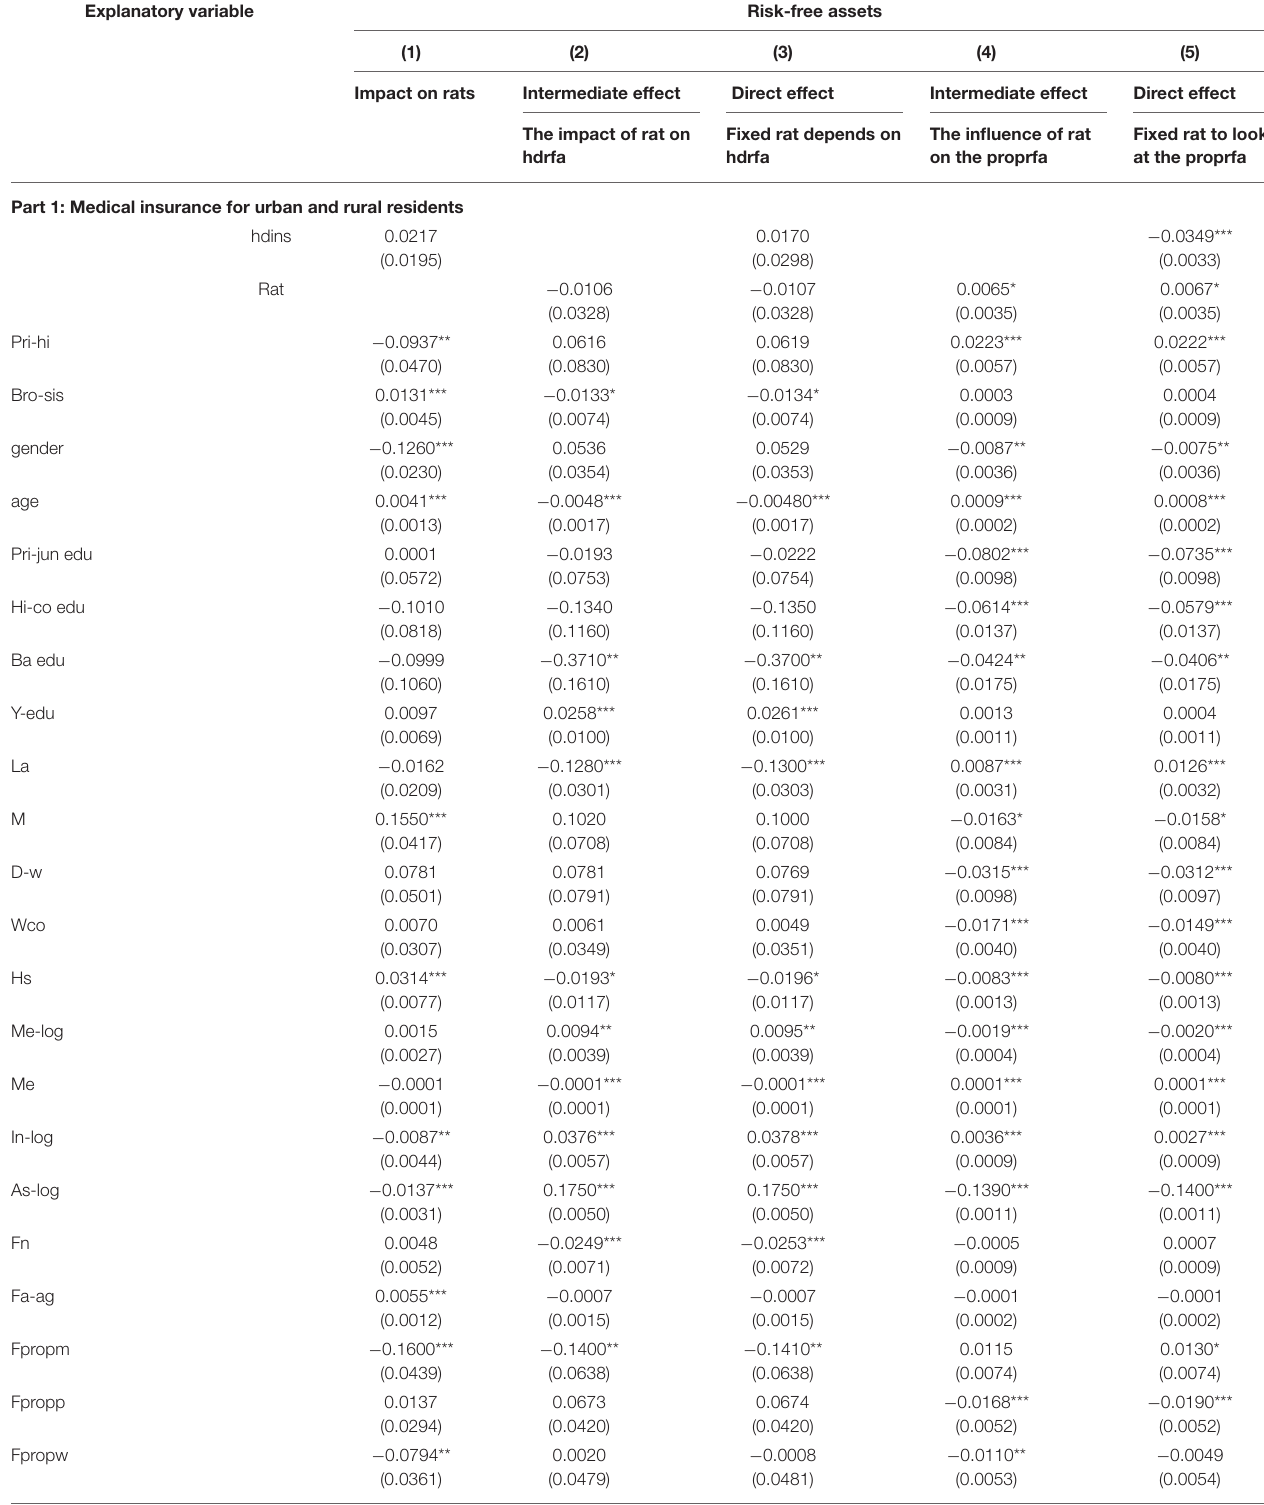
TABLE 4 | Intermediary effect regression (risk-free